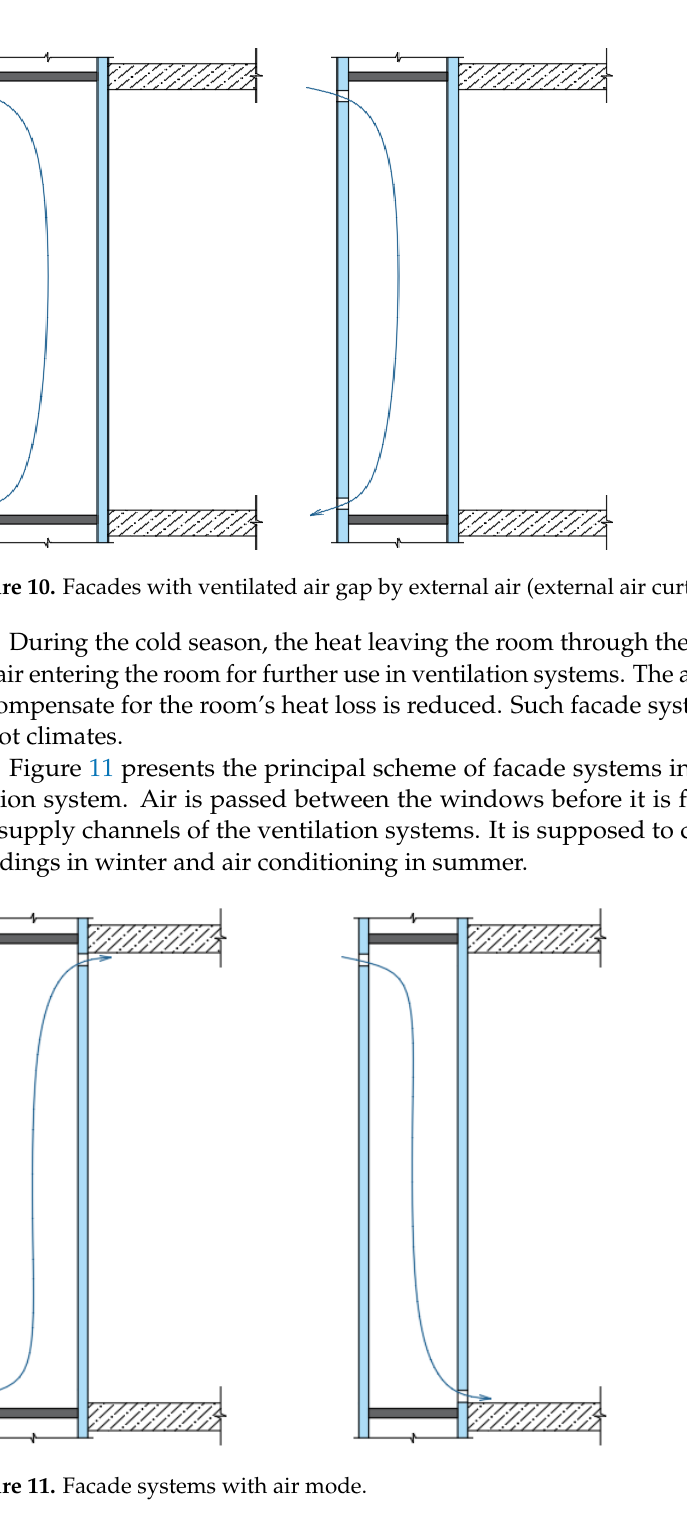
Figure 11. Facade systems with air mode.